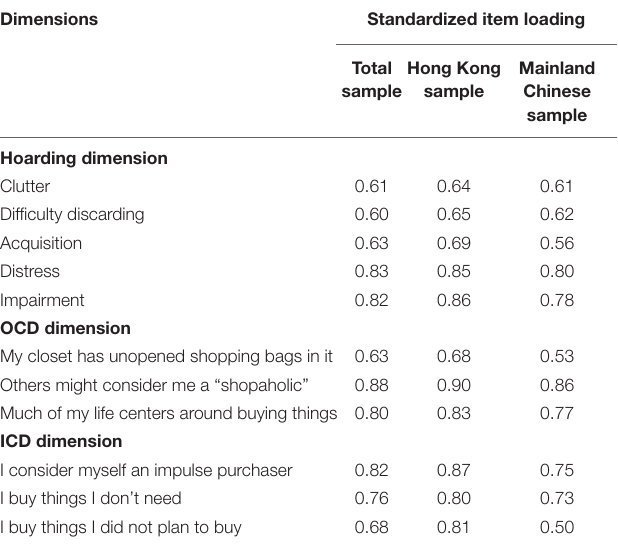
TABLE 2 | Goodness-of-fit indices within hoarding, OCD and ICD dimensions. Dimensions